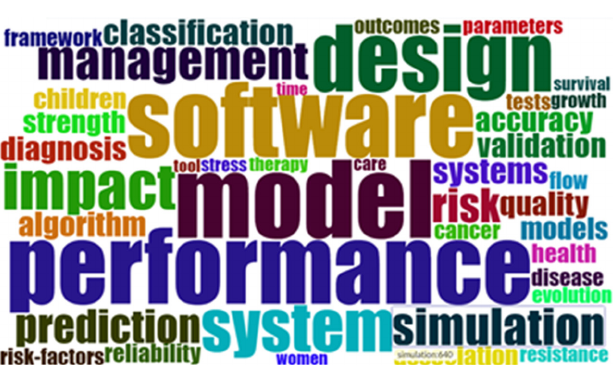
Figure 13. Co-word analysis constituting the top 20 keywords for the time duration (2016–2018).